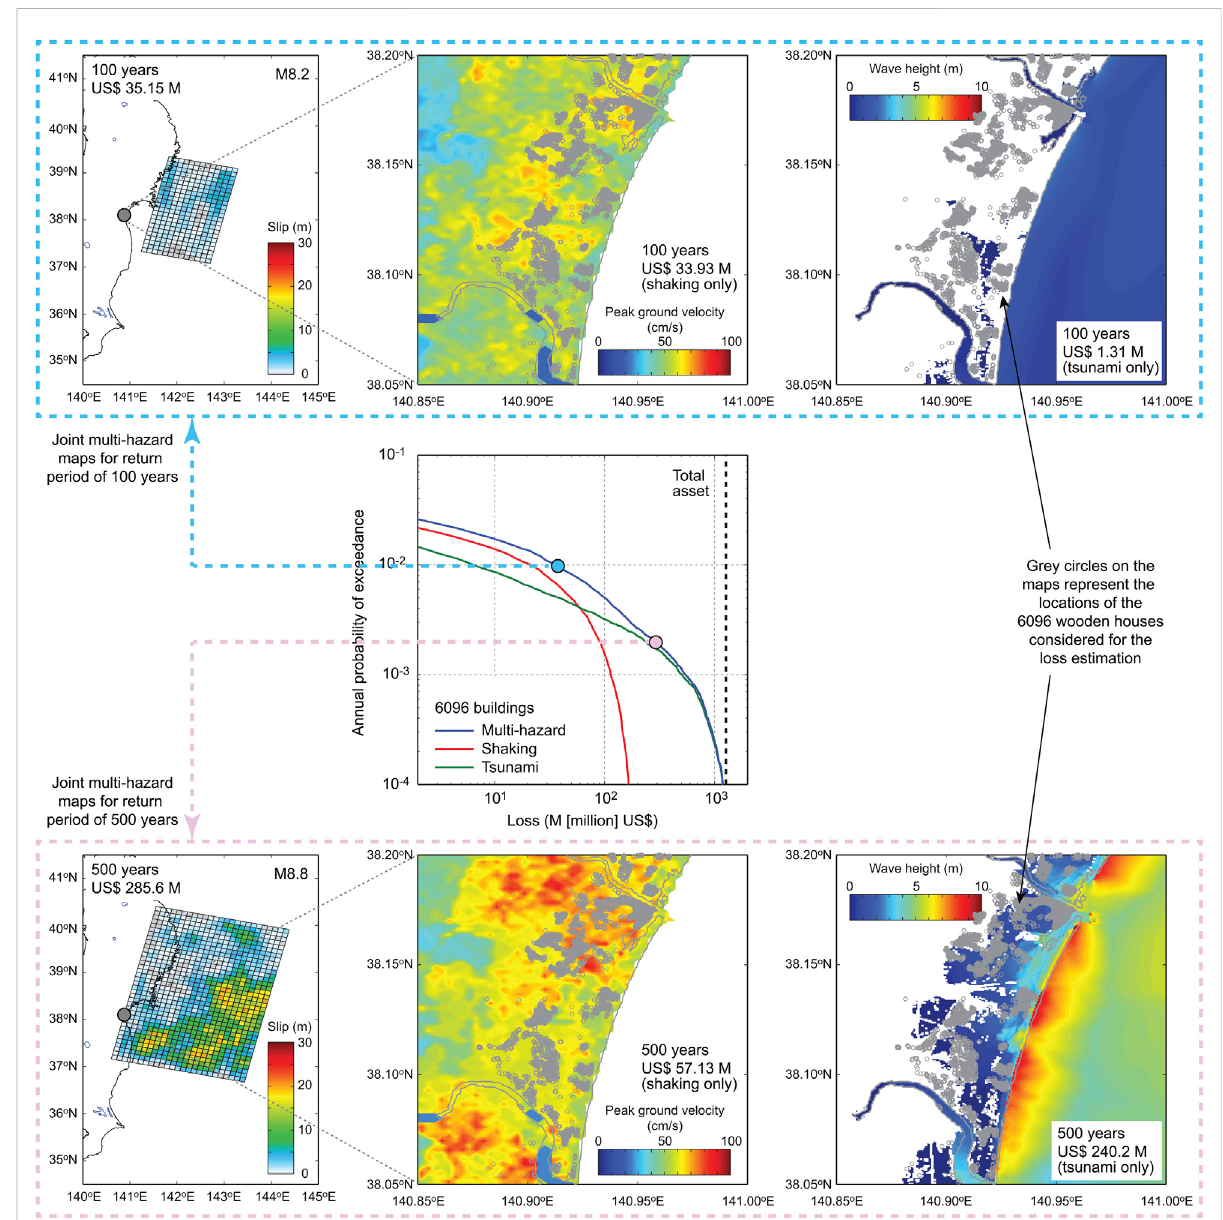
FIGURE 5 Example of multi-hazard loss curves and joint multi-hazard maps for shaking and tsunami risks (modi fi ed after Goda and De Risi (2018)). The seismic intensity is represented by peak ground velocity, whereas the tsunami intensity is represented by tsunami height.